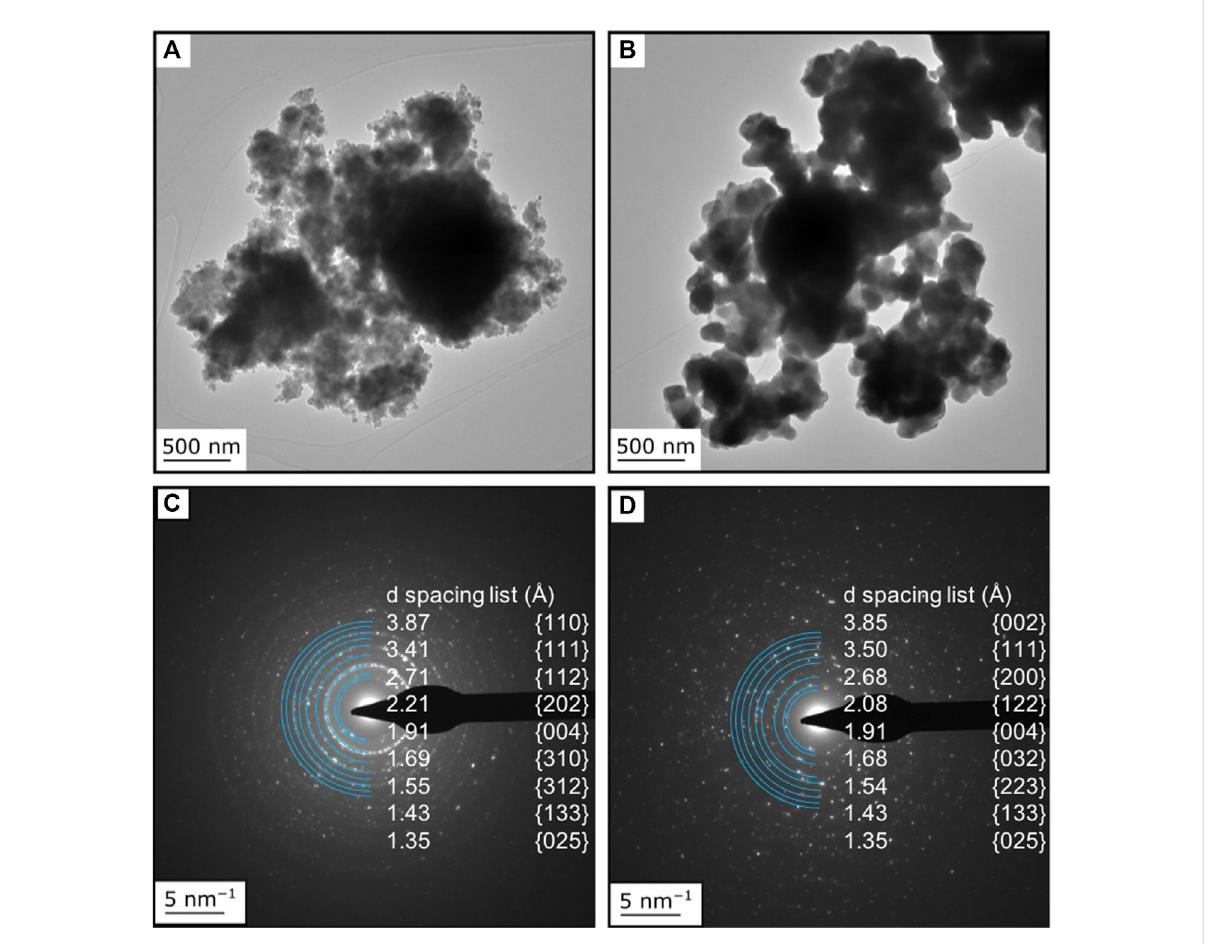
FIGURE 7 TEM images of (A) HEO-Sr_BM, (B) HEO-Sr_PM and SAED pattern for (C) HEO-Sr_BM and (D) HEO-Sr_PM with list of lattice spacings and corresponding hkl-planes of the Pbnm perovskite structure. HEO-La_PM and HEO-Sr_PM were calcined at 1,200 ° C for 12 h in